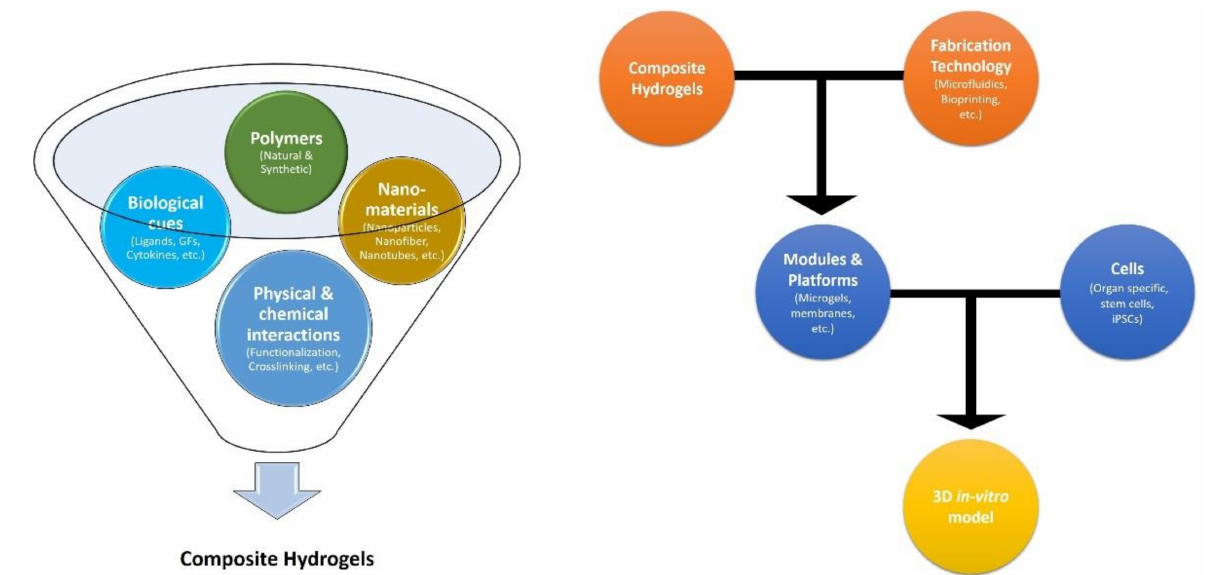
Figure 2. Schematic representation of various factors and components in the development of hydro- gels and hydrogel-based in vitro 3D